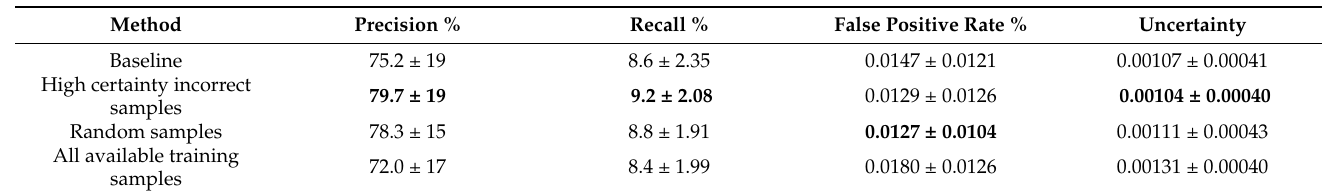
Table 3. Comparison of Detection Performance for Pre- and Post-Feedback.